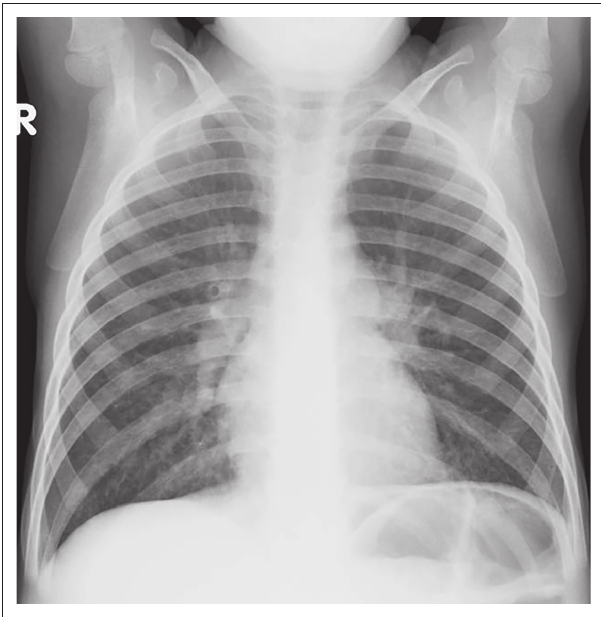
FIGURE 6: 4 year-old boy with newly diagnosed HIV. Frontal chest radiograph shows symmetric reticulo-nodular pattern opacities as well as hilar lymphadenopathy from LIP.